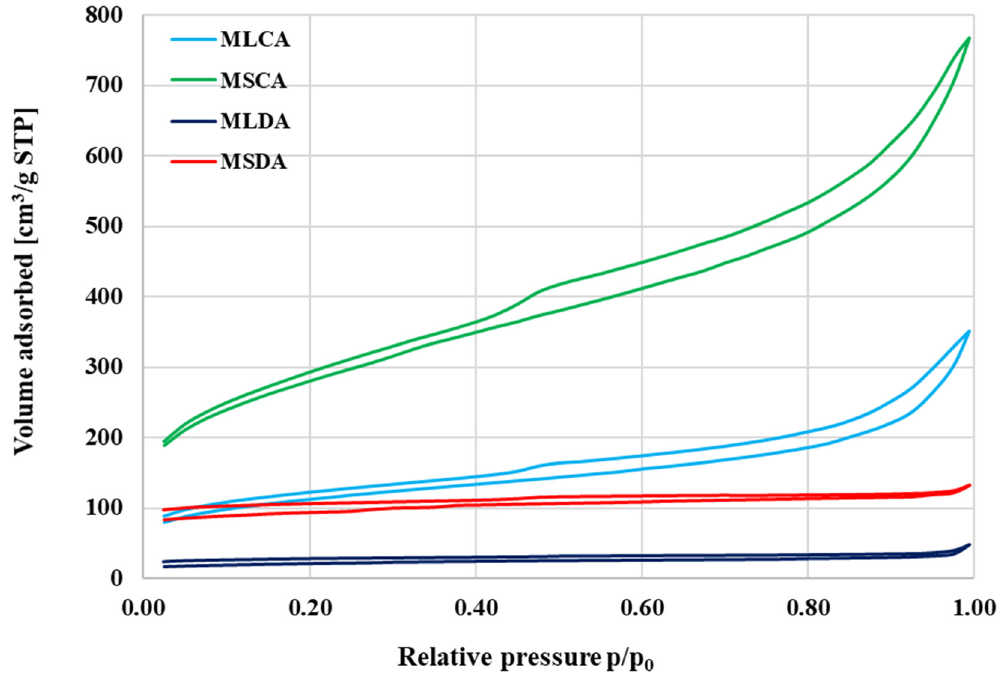
Figure 2. Low-temperature nitrogen adsorption/desorption isotherm for the activated biocarbons prepared from mugwort post-extraction residue.